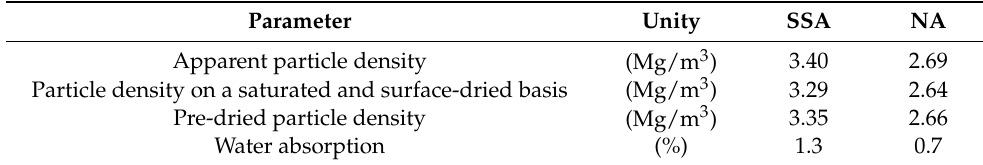
Table 1. Result of SSA and NA particle density and water absorption.